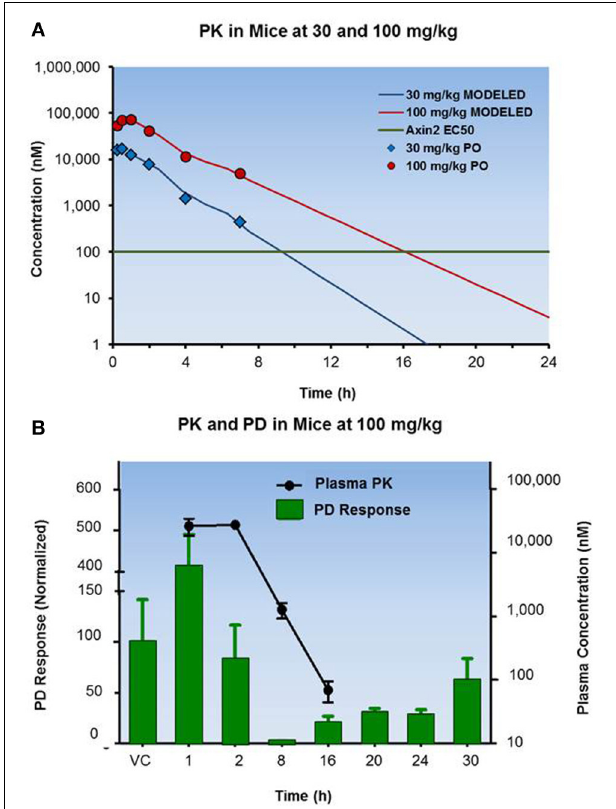
FIGURE 3 | PK and PD profiles of an oncology drug candidate in a mouse xenograph model. (A) Displays the pharmacokinetic profiles of a compound following oral administration at 30 and 100mg/kg to mice. (B) Illustrates the PK/PD results at 100mg/kg with the drug showing return of the PD response to